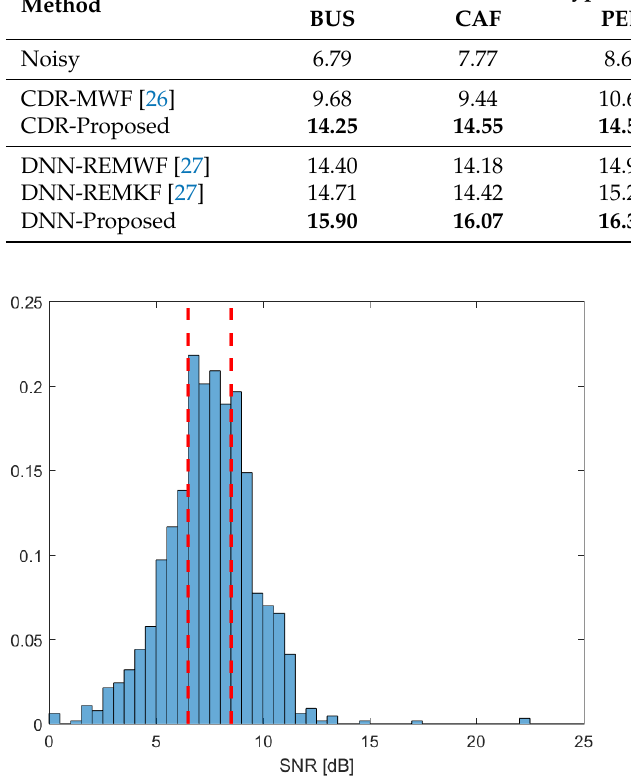
Table 3. The average SISDRs (in dB) for the different algorithms depending on the noise type. Method